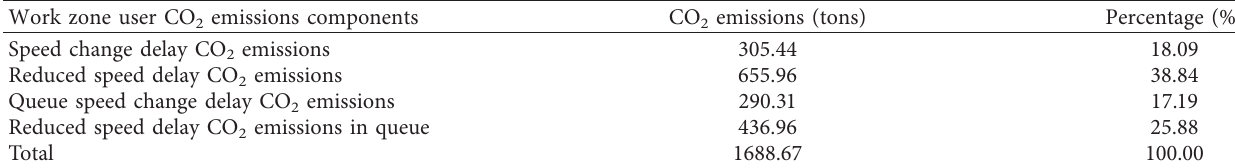
Table 3: Work zone user CO 2 emissions components of maintenance event in life cycle of case freeway pavement (from 2007 to